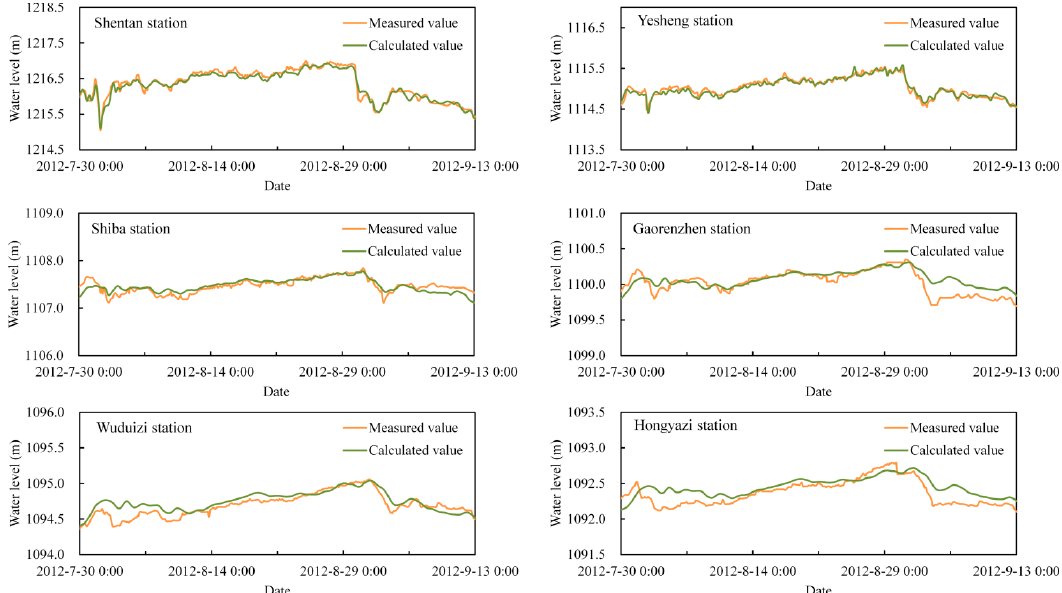
Figure 5. Model calibration based on the actual measured data of the flood processes at the different stage gauging stations of the NRYR in 2012.